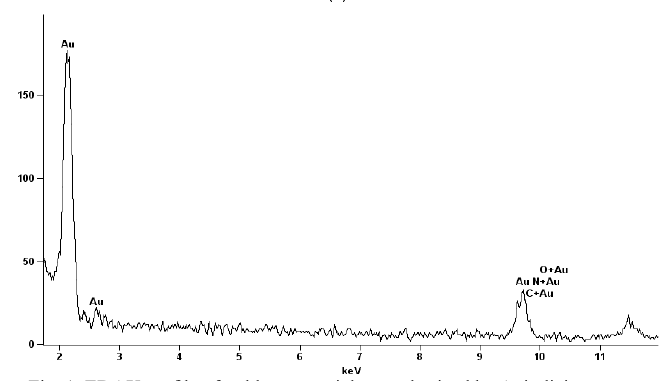
Fig. 1. EDAX profile of gold nanoparticles synthesized by A. indicia extract.